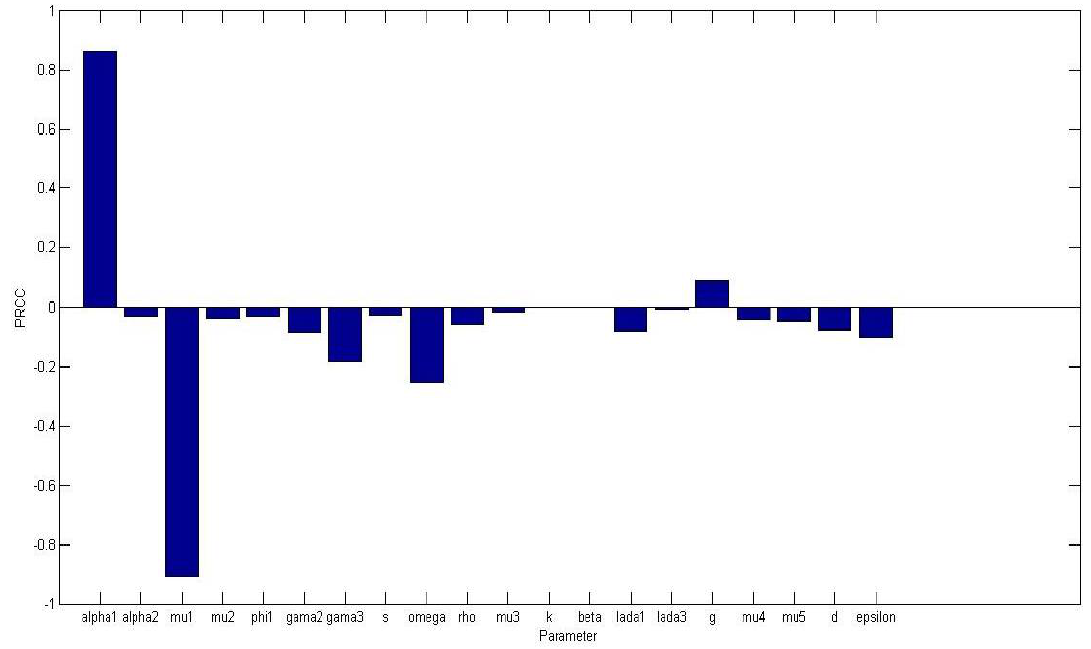
Figure 1. PRCCs of homogeneous model parameters with the tumor cells as the baseline variable. All parameter values were varied in 25 % of their baseline values in Table 1. The most sensitive parameters are shown to be P − values of α 1 , g , µ 1 , γ 3 and ω are less than 0.01. Table 1. Description of parameters in the